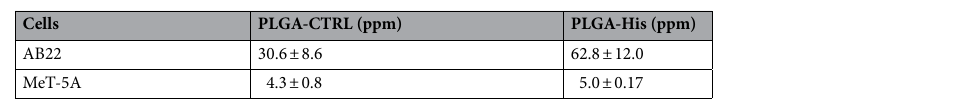
Table 4. Maximum ppm of boron internalized in AB22 and MeT-5A after 24 h incubation in the presence of PLGA-CTRL or PLGA-His.